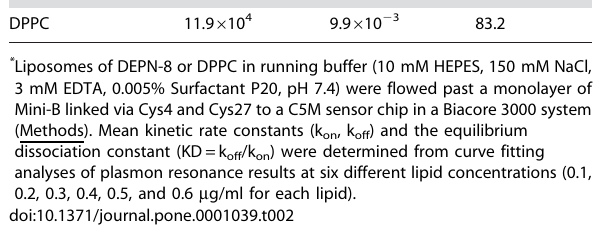
Lipid compound* k on (1/Ms)